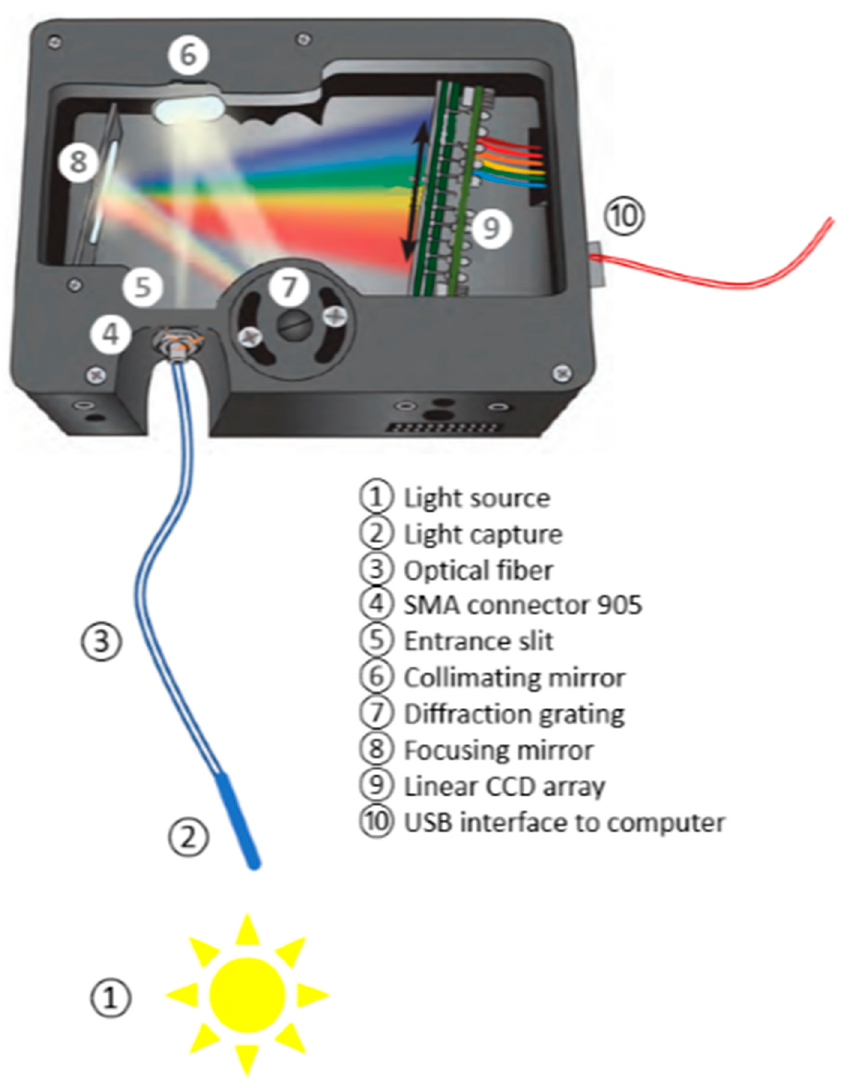
Figure 2. Operating diagram of an optical spectrometer such as the one used in this study [34]. Table 1. Comparison of specifications of spectrometers used [35].